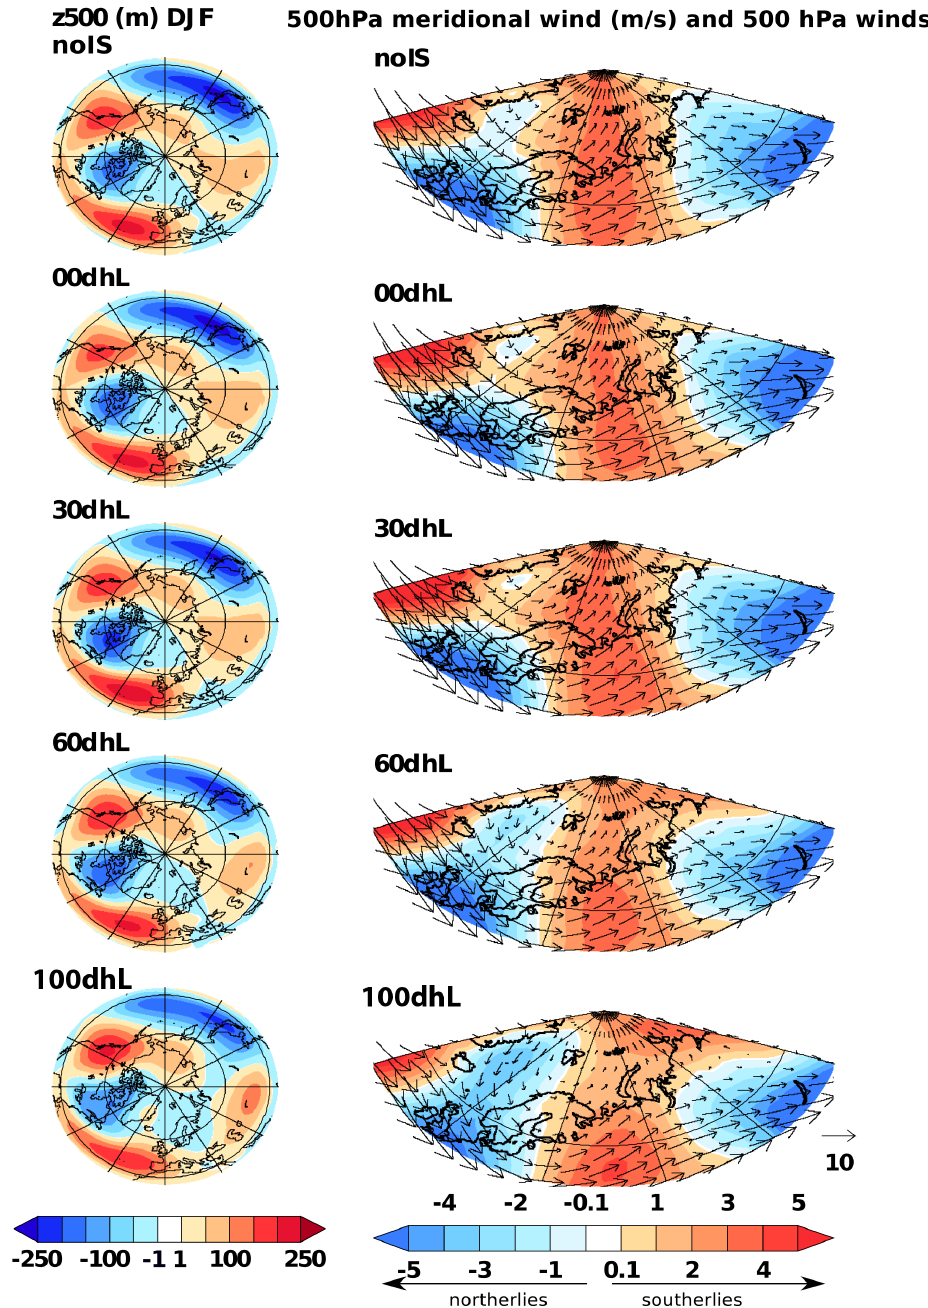
Figure 5. Same as Fig. 4 for the winter season.